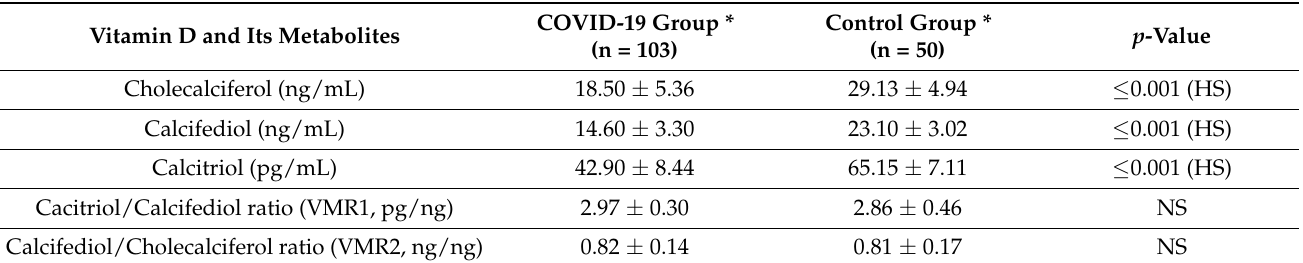
Table 3. Serum levels of vitamin D3 and its metabolites in COVID-19 positive group compared with control group.